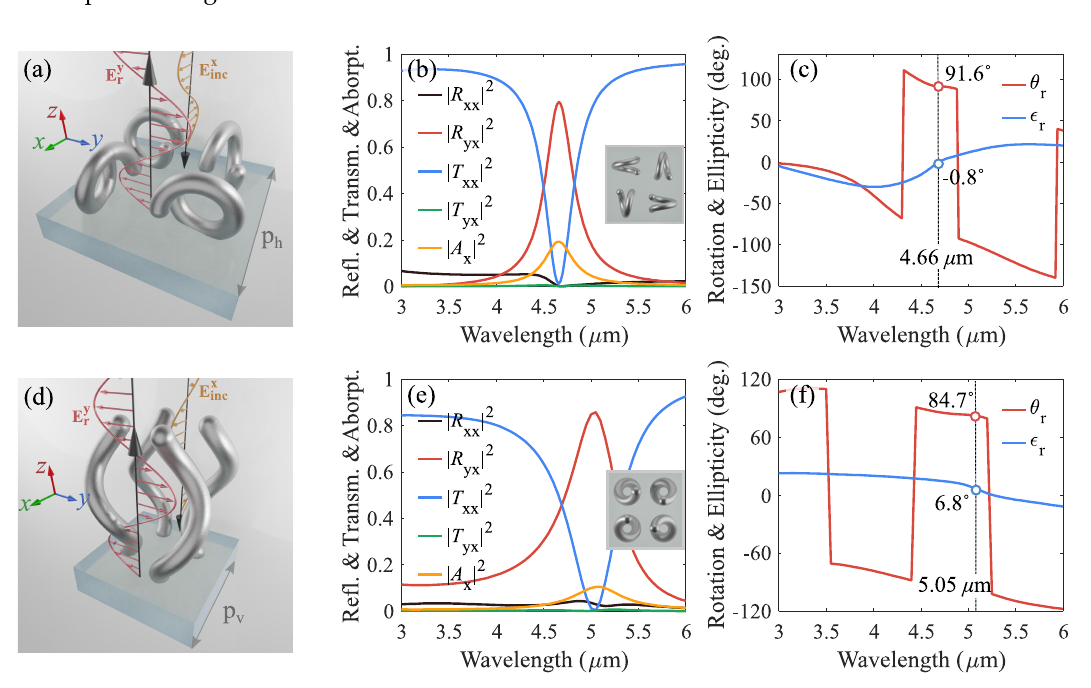
Figure 5. ( a ) The designed unit cell of a metasurface consists of horizontally-oriented helices with the lattice period of p h = 1.8 µ m for cross-polarized reflection regime. ( b ) Reflectance, transmittance, and absorbance spectra with the top view of the unit cell in the inset. ( c ) The rotation and ellipticity wavelength dependence of the metasurface. ( d ) The unit cell of a metasurface consists of vertically oriented helices with a lattice period of p v = 1.2 µ m. ( e ) Co- and cross-polarized reflectance, transmittance, and absorbance spectra with the top view of the unit cell in the inset. ( f ) The rotation and ellipticity wavelength dependence of the corresponding